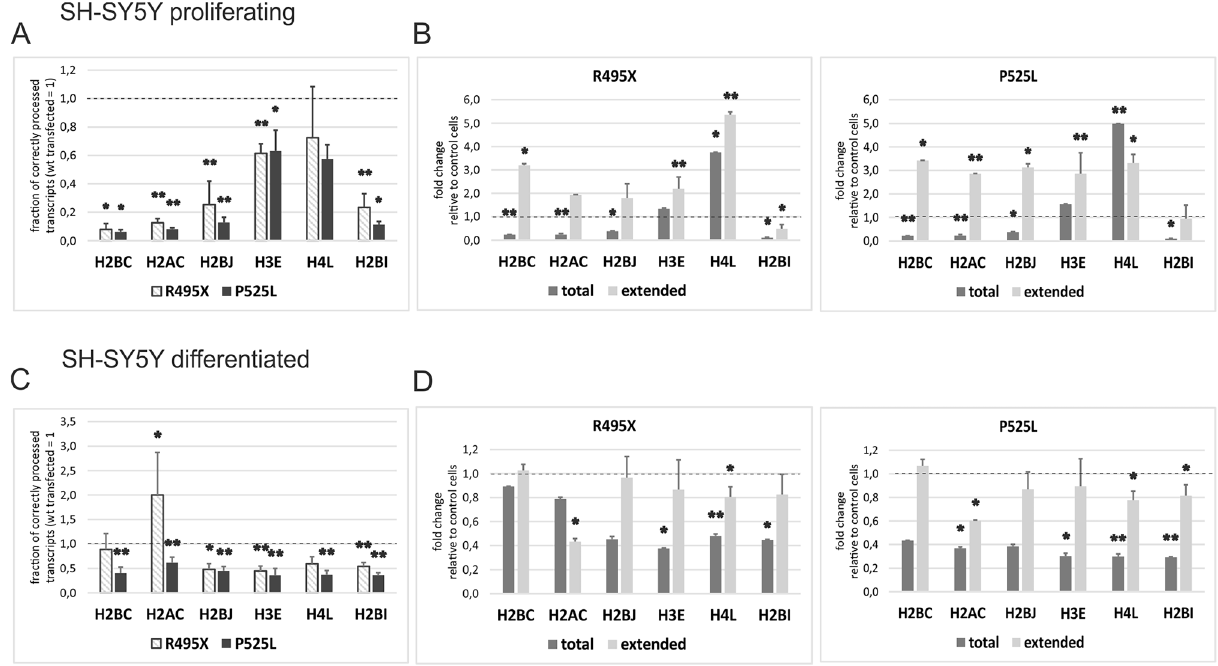
Figure 2. Replication-dependent histone gene expression in cells transfected with plasmids carrying FUS WT and ALS-linked FUS mutations. ( A ,C) The fraction of correctly cleaved histone mRNAs in the proliferating ( A ) and differentiated ( C ) cells transfected with the FUS mutants compared to the cells transfected with wild- type FUS displayed as the ratio of total to unprocessed (extended transcripts). ( B , D ) Fold enrichment of total and extended transcripts in the cells transfected with the FUS mutants compared to the cells transfected with wild-type FUS. H2A.Z was used as a reference gene. Error bars represent the SD of three biological replicates. P-values were calculated using Student’s t-test, and the statistical significance is represented as follows: *P ≤ 0.05; **P ≤